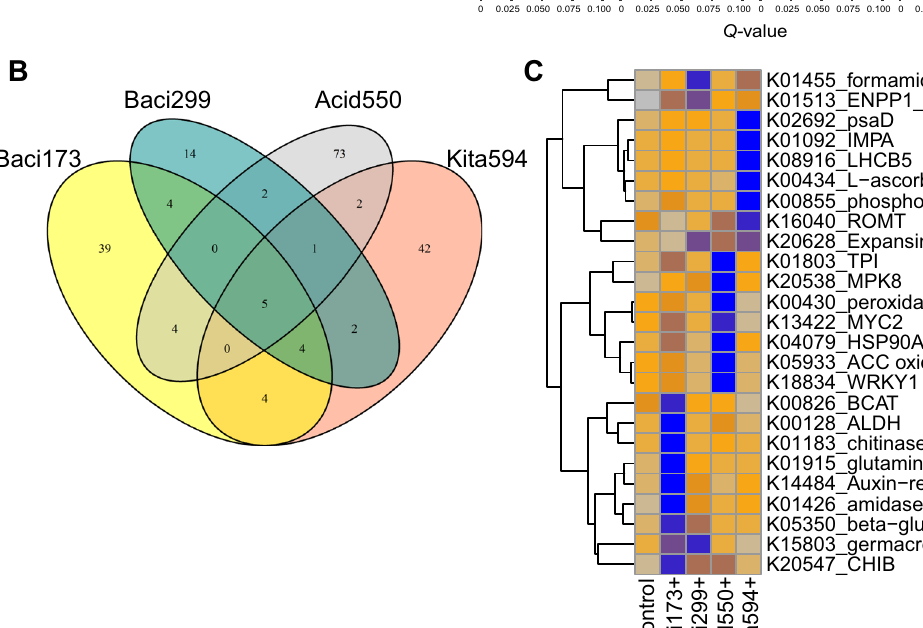
Fig. 4 | Marker strains induce distinct genes in foxtail millet. A KEGG enrich- ment analysis of differentially expressed genes in Baci173-, Baci299-, Acid550-, Kita594-inoculatedseedlings.Thedifferentiallyexpressedgenesrepresentthe genes that were signi fi cantly upregulated or downregulated in seedlings inoculatedwithmarkerstraincomparedwithcontrol.Circlesizerepresentsthe